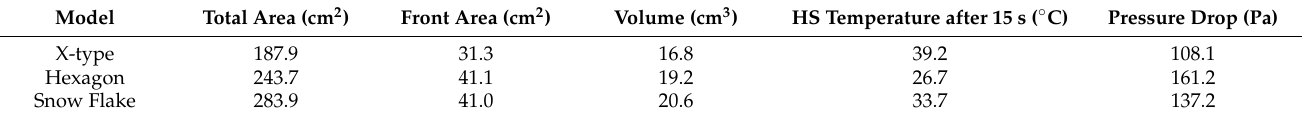
Table 10. Temperature and pressure drop for each pin heat sink model.